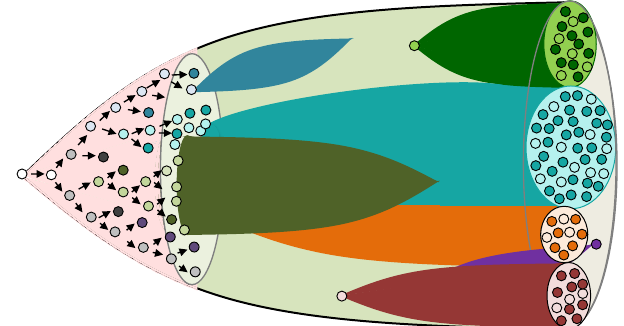
Figure 1 | Schematic depiction of the subclonal evolution and diversification of cell types in developing malignant populations. In this diagram, subclones identified by accumulating genetic changes are shown by different colours. Cells within each clone that have proliferative potential are shown as pale cells in contrast to some of their progeny that can no longer divide that are shown as dark cells (to illustrate the diversification of biological properties that occurs both within and between subclones), with some clones being transient, whereas others are persistent but variably